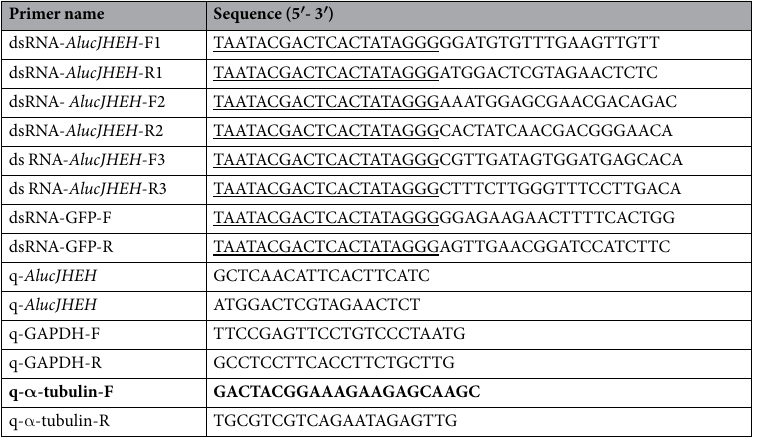
Table 1. Primers used in the study. Note: The sequences underlined were T7 promotor sequences. The primers with ds-prefixed were used as ones of dsRNA, and the primers with q-prefixed were used as ones of SYBR-Green